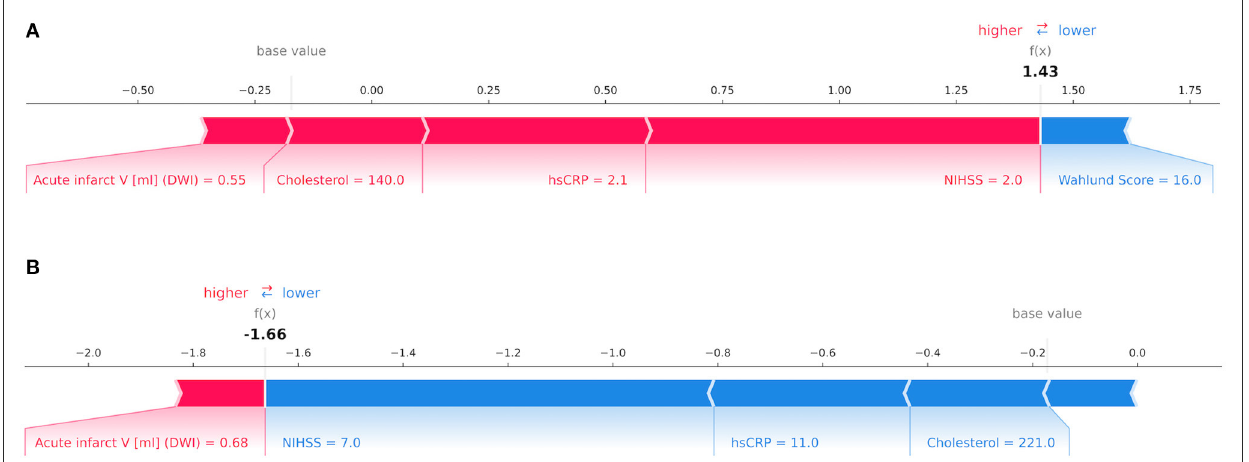
FIGURE4 Decision-making process by the Gradient Boosting Classifier for the modified Rankin Scale (mRS) at patient discharge on the level of individual patients depicted via Shapley values. The relative importance of an input variable can be quantified by its Shapley value and represented by the length of a bar. In this example, features in red counted toward a good outcome while blue features signified poor outcome for mRS at patient discharge. In (A) a patient with a mRS score of 1 point was correctly classified as having a good outcome with variables such as low National Institutes of Health Stroke Scale (NIHSS), high-sensitivity C-reactive protein (hsCRP), cholesterol and acute infarct volume in Diffusion-weighted imaging (DWI) outweighing a high Wahlund Score. In (B) a patient with a mRS score of 4 points was correctly predicted as having poor outcome due to high